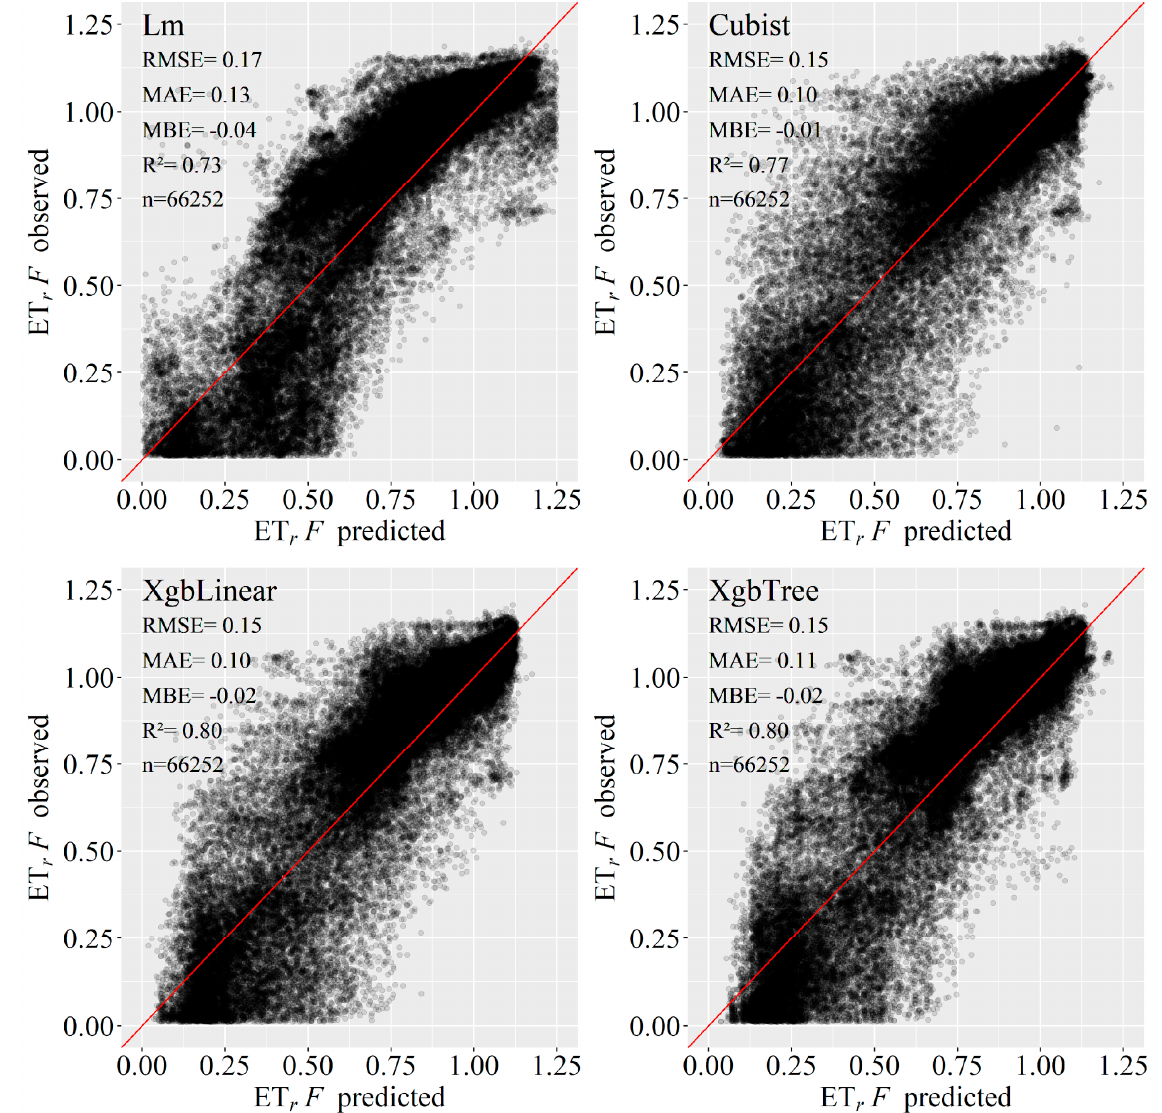
Figure 6. Statistical results of the test of approach 1.